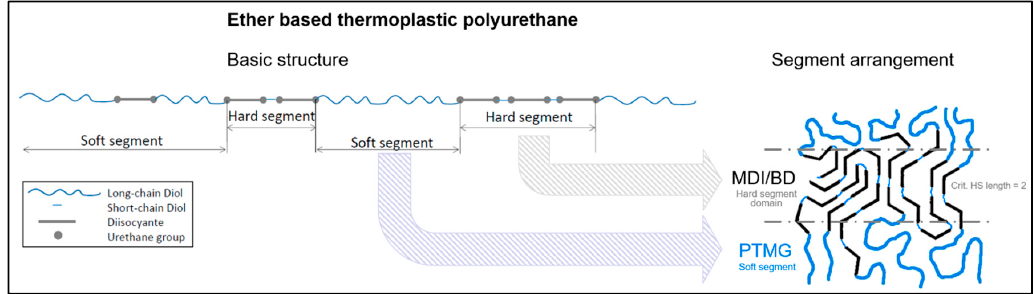
Figure 1. Schematic example of the arrangement of ether based thermoplastic polyurethane consisting of methylendiphenylisocyanate (MDI)/BD hard and PTMG soft segments after [13,17,18,26].